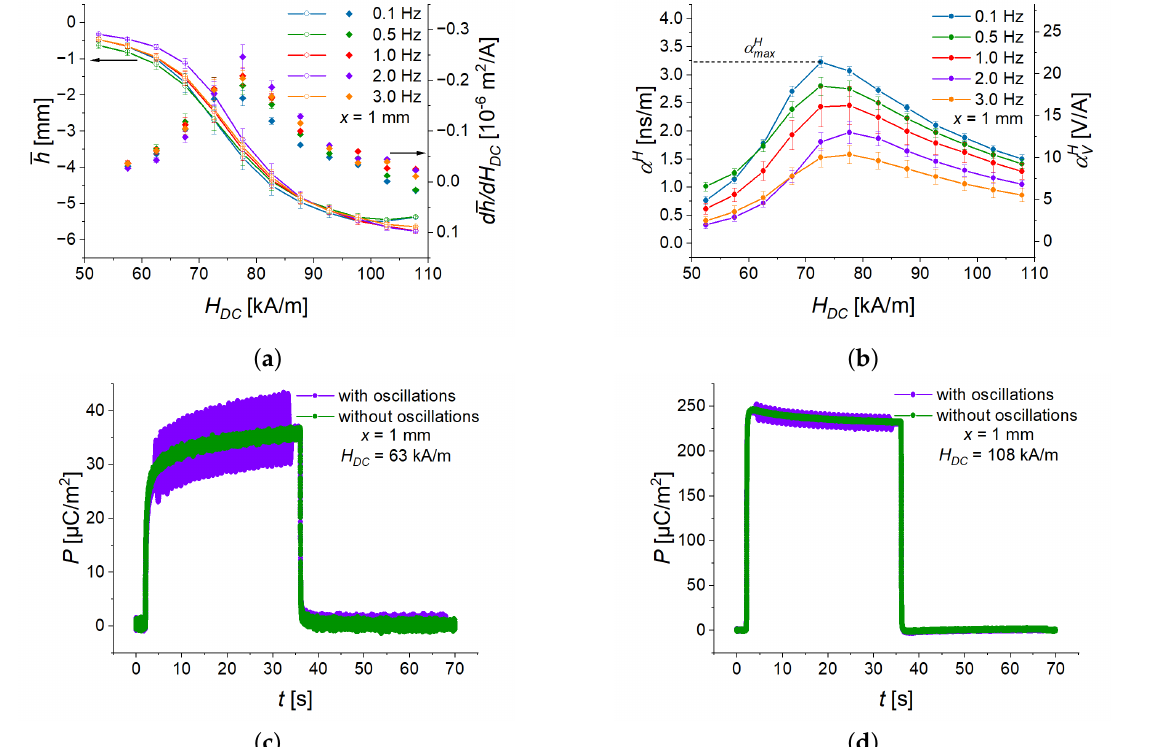
Figure 15. ( a ) Field dependences of the deflection and its derivative with respect to the constant magnetic field. ( b ) Field dependences of the ME coupling coefficient for five different frequencies. Examples of the transient behaviour of polarization for the excitation current of 1.2 A ( c ) and 2.1 A ( d ). As an example, α H max shows the maximum value of α H for f = 0.1